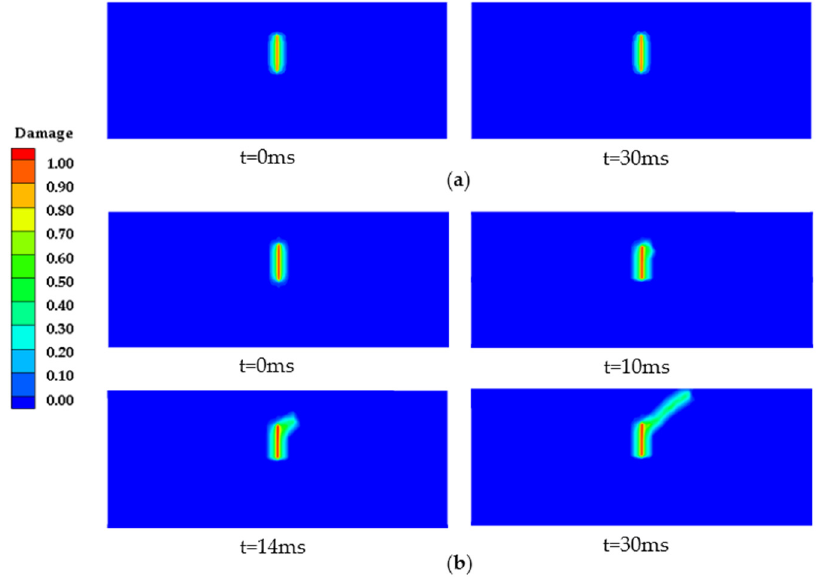
Figure 11. Crack propagation under different forms of loads. ( a ) Damage cloud image under sym- metrical load; ( b ) damage cloud image under asymmetrical load.